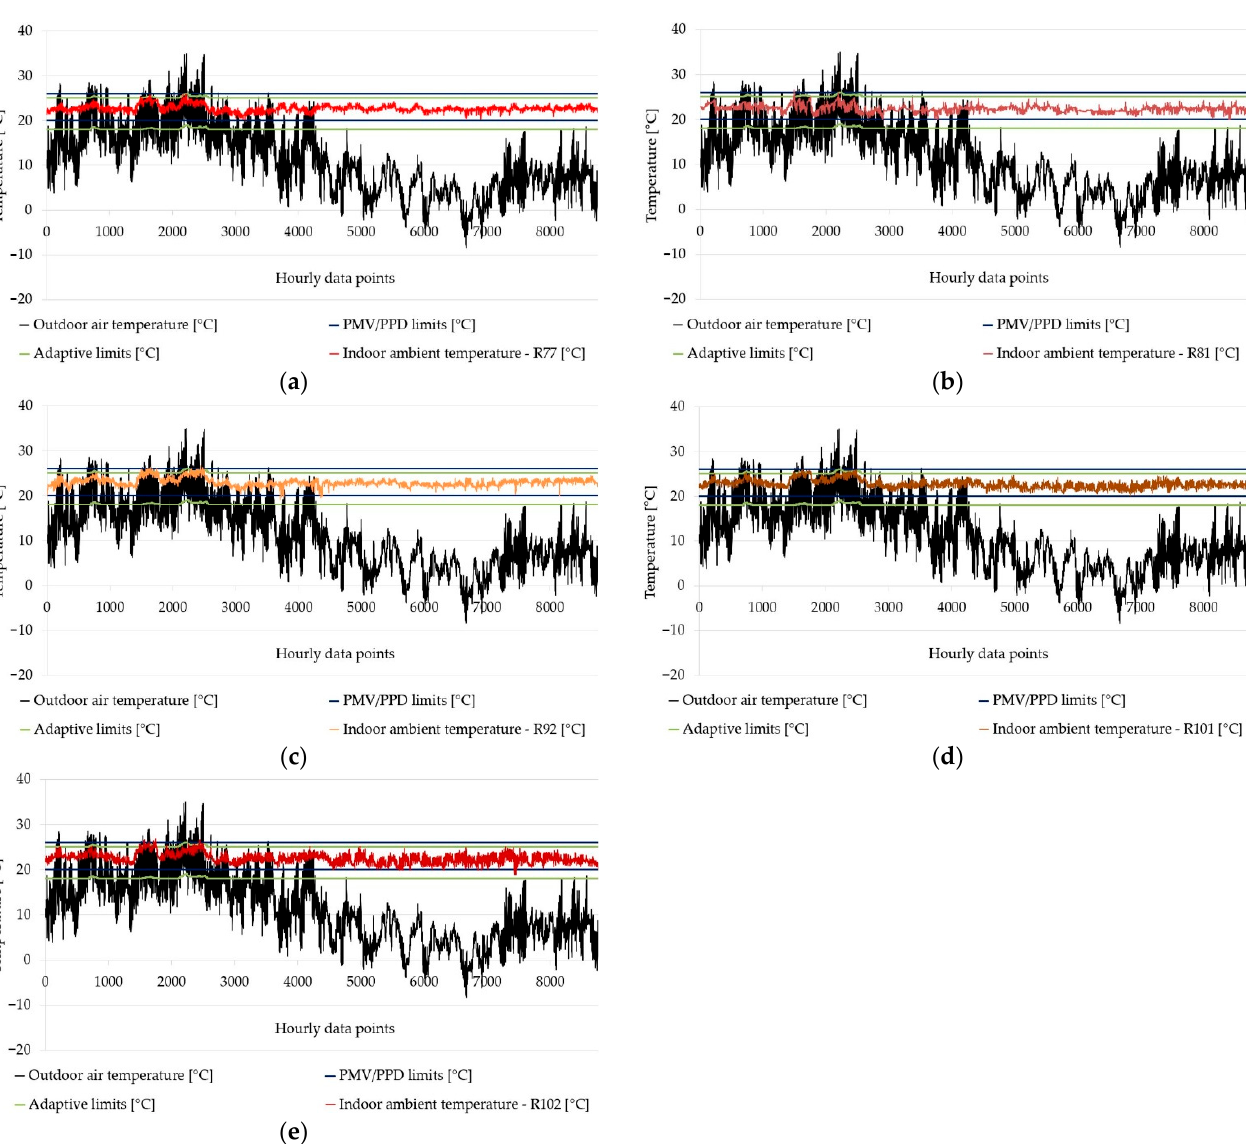
Figure 6. Building overheating value using 𝐼𝑂ℎ𝐷 and overcooling value using 𝐼𝑂𝑐𝐷 from May 2018 to April 2019.